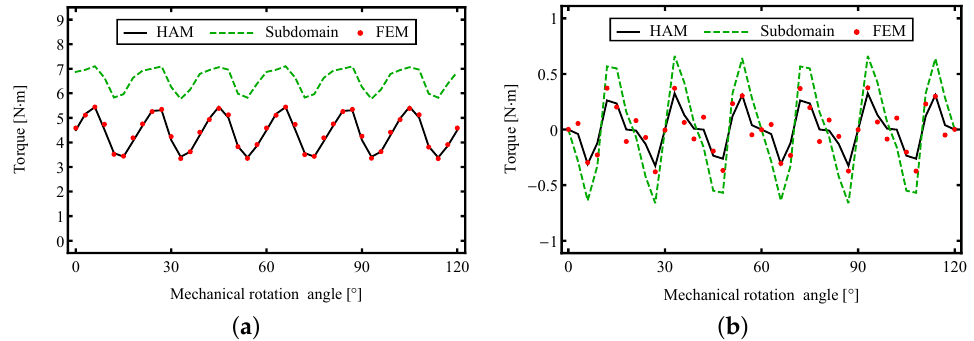
Figure 22. Comparison of torque pulsation of Machine II: ( a ) torque ripple with a current of 20 A (maximal amplitude); ( b ) cogging